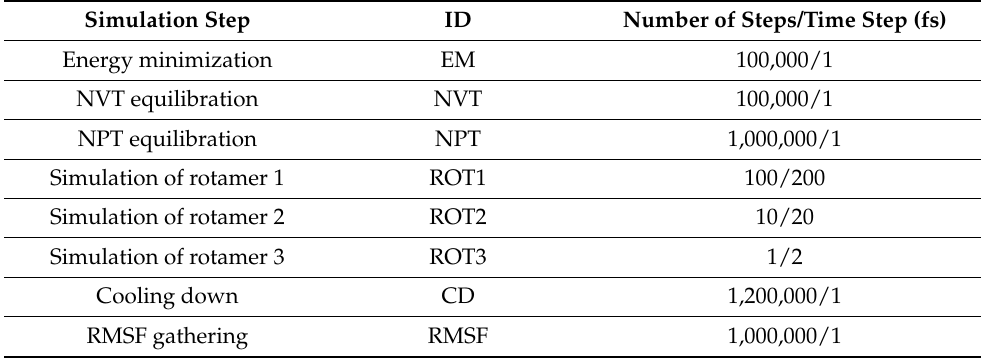
Table 1. Simulation steps with their IDs and the number of steps/time